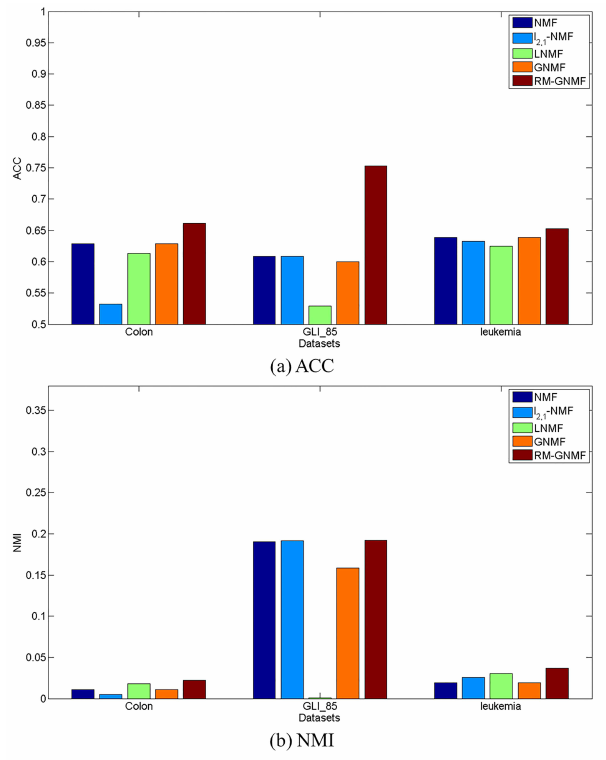
Figure 2. Clustering results on different